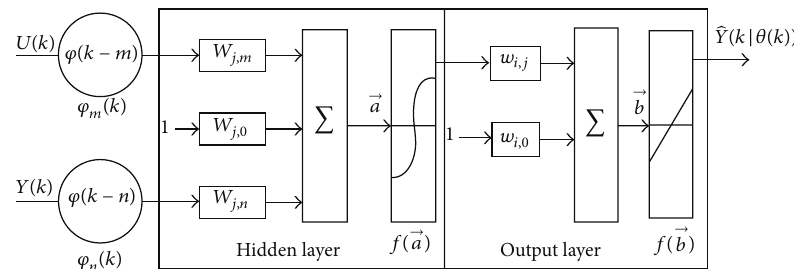
Figure 4: NN structure and its